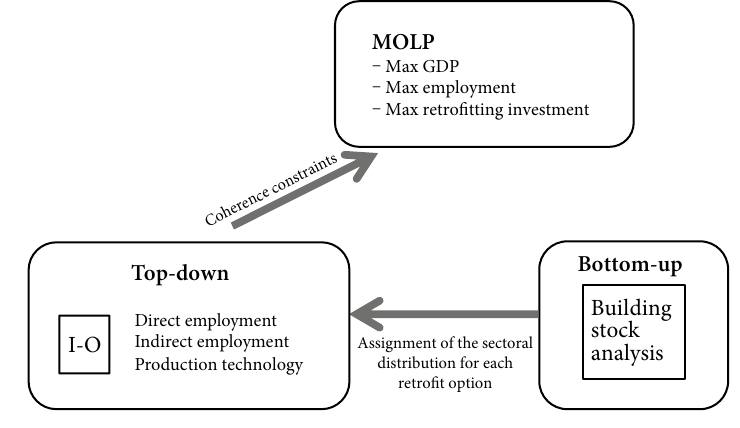
Fig. 2. New structure of the MOLP I-O